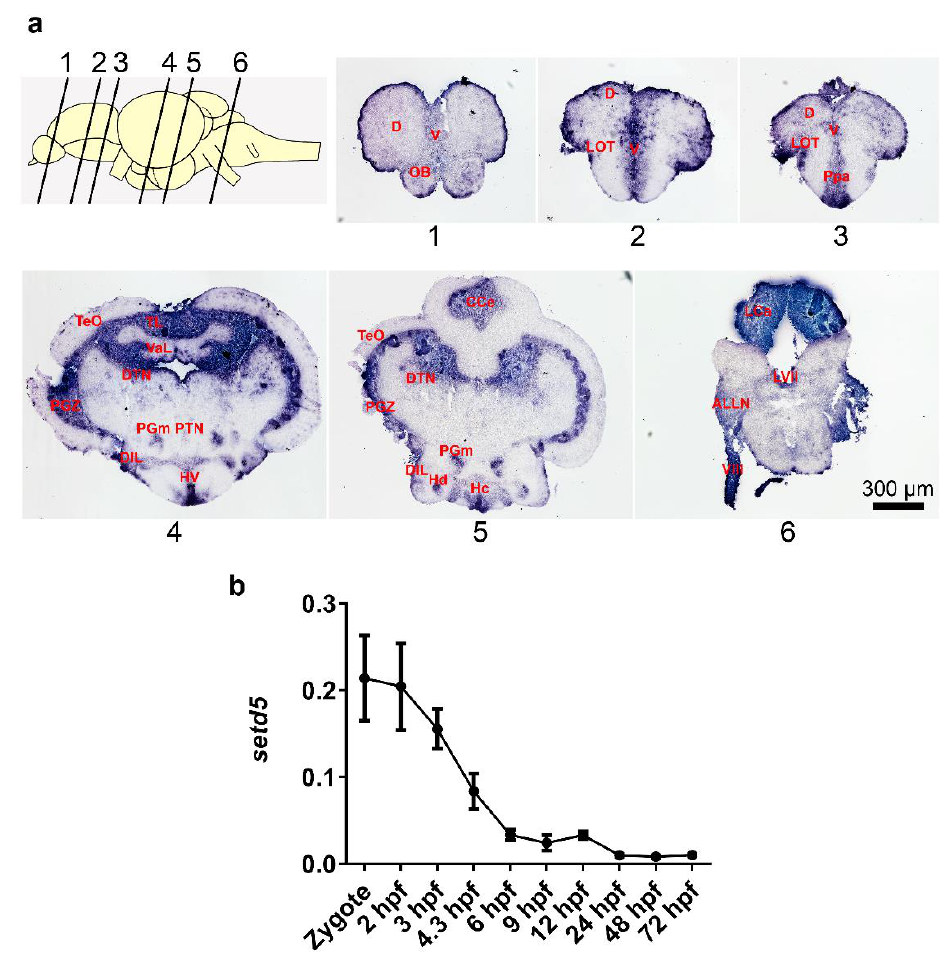
Figure 1. setd5 is expressed in the zebrafish adult brain and at early stages of zebrafish embryo development. ( a ) setd5 -203 isoform localization on zebrafish WT brain sections at 10/12 months of age performing in situ hybridization technique. Representative images of a section corresponding to telencephalon (1 – 3), diencephalon-mesencephalon (4,5) and rhombencephalon (6), n = 3 brains analyzed. Scale bar 300 µm. ( b ) Expression of setd5 isoforms in zebrafish embryos and larvae at different developmental stages, obtained by RT-qPCR analysis. Data are expressed as 2 −(ΔCt) mean ± Standard Error of the Mean (SEM), using b-actin1 as housekeeping gene. n = 3 independent experiments. Abbreviations: D, Dorsal telencephalic area; V, Ventral telencephalic area; OB, Olfactory bulb; LOT, Lateral olfactory tract; Ppa, Parvocellular preoptic nucleus; TL, Longitudinal Torus; Val, Lateral division of valvular cerebelli; TeO, Tectum opticum; PGZ, Periventricular gray zone of optic tectum; DTN, Dorsal tegmental nucleus; HV, Ventral zone of periventricular hypothalamus; PTN, Posterior tuberal nucleus; PGm, Medial progromerular nucleus; DIL, Diffuse nucleus of the inferior lobe; Hc, Caudal zone of periventricular hypothalamus; Hd, Dorsal zone of the periventricular hypothalamus; CCe, Cerebellar corpus; LCa, Caudal lobe of cerebellum; LVII, Facial lobe; ALLN, Anterior lateral line nerves; VIII, Octaval nerve; hpf, hours post fertilization.